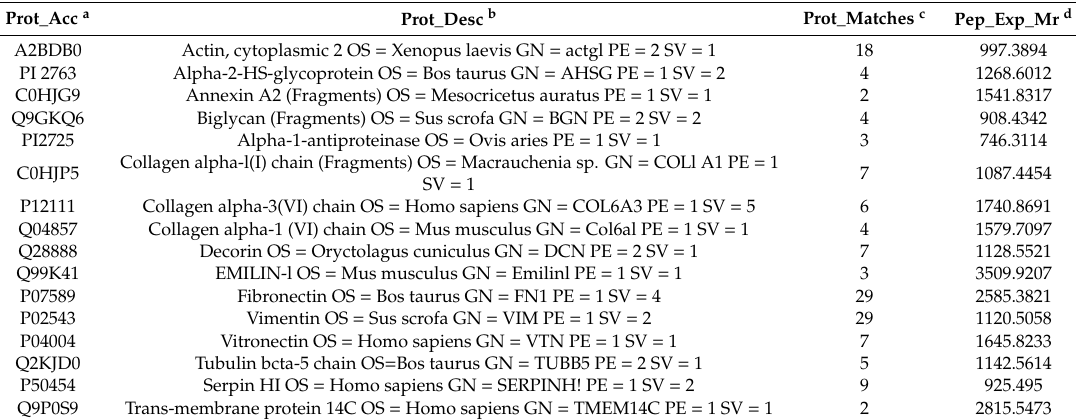
Table 1. ADSC ECM components determined using LC–MS / MS analysis.